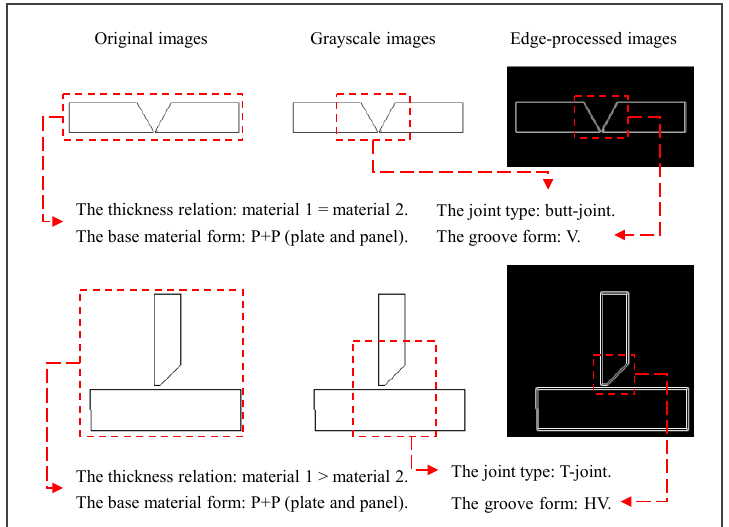
Figure 4. Pre-processing results and characterization. The original images are shown on the left, the middle images show the grayed-out images, and the right images show the edge detection results based on the Sobel operator.